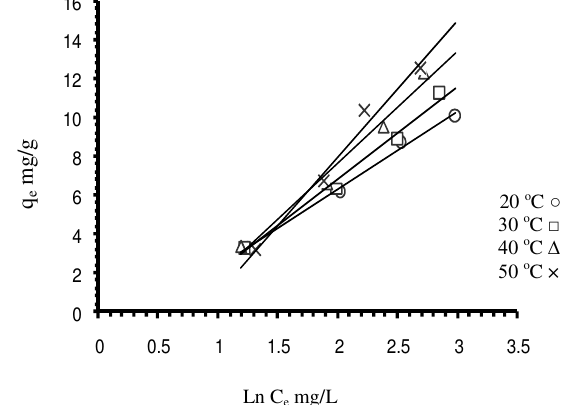
Figure 8. Temkin isotherm for the adsorption of MPGP at different temperatures.